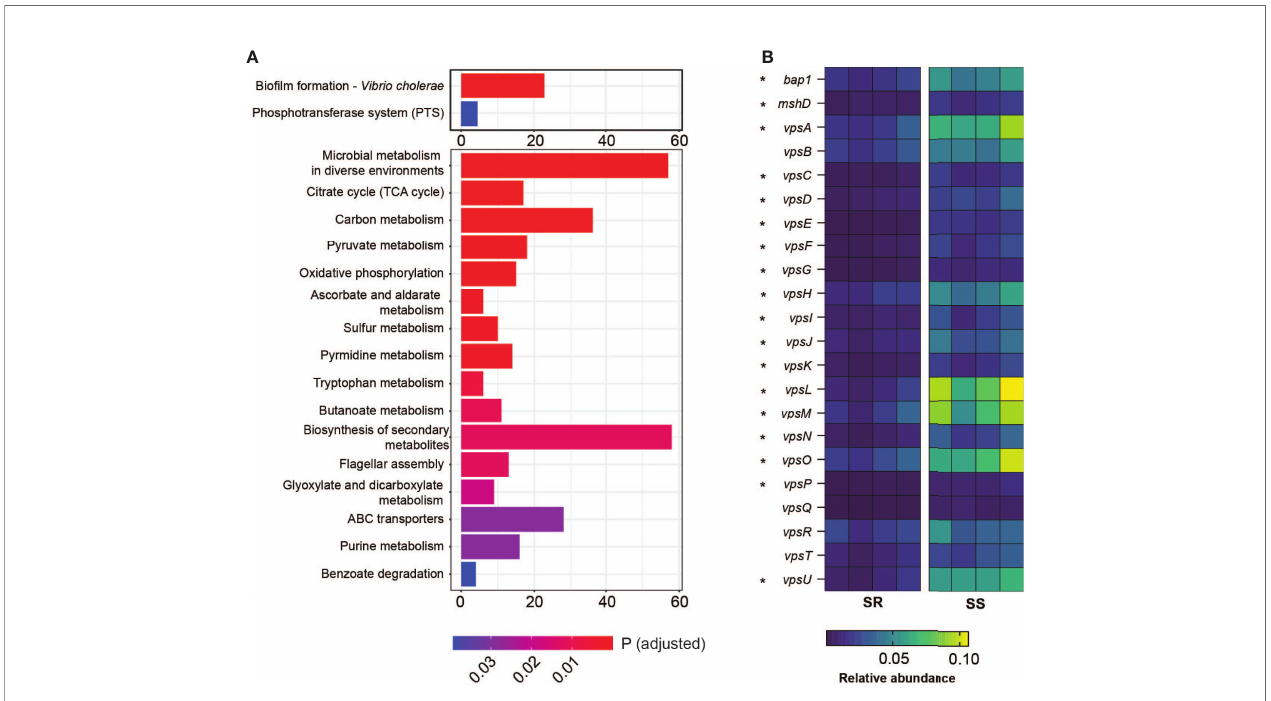
FIGURE 2 | Differential gene regulation in V. cholerae on coinfection with different model communities. (A) Number of genes involved in indicated KEGG gene pathways relatively signi fi cantly upregulated in V. cholerae coinfected with SS vs. SR (upper panel) and SR vs. SS (bottom panel). (B) Relative abundance (%) of genes involved in Vibrio polysaccharide formation and attachment from V. cholerae coinfected with SR or SS. Starred genes (*) are signi fi cantly differentially expressed across microbiota groups (*P <